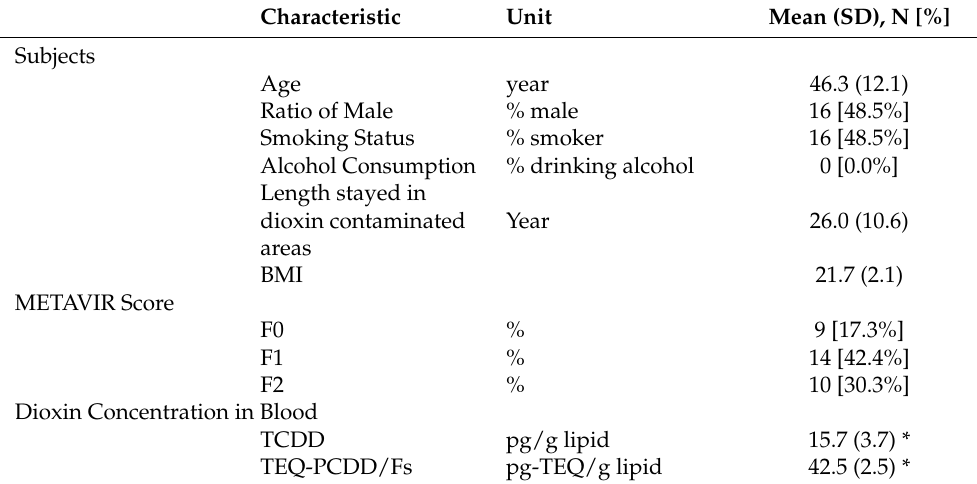
Table 1. Characteristics of the study subjects.